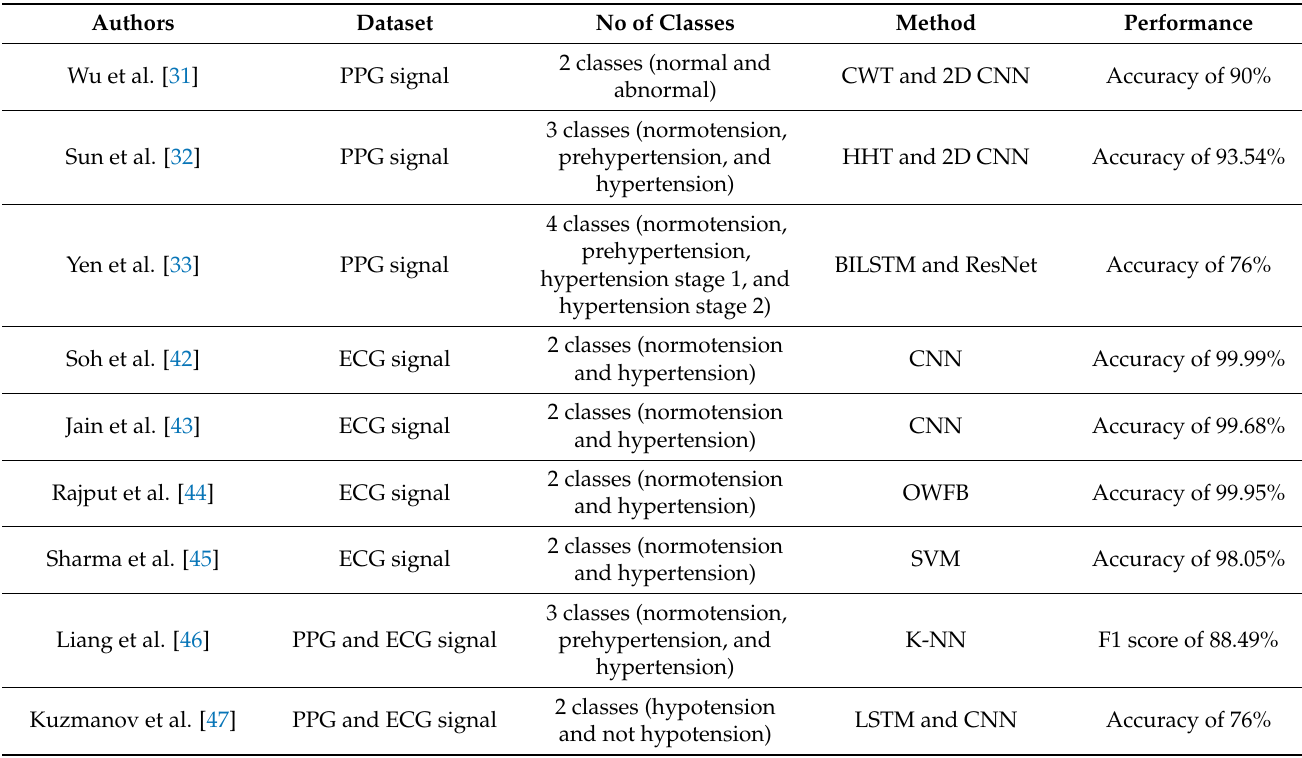
Table 4. The performance comparison with previous